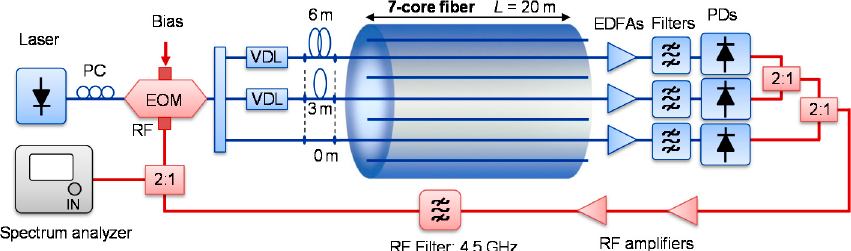
Figure 8. Setup for the experimental demonstration of a multi-cavity Vernier optoelectronic oscillator over a seven-core homogeneous fiber. PC: polarization controller; RF: radiofrequency; EOM: electro-optic modulator; VDL: variable delay line; EDFA: Erbium-doped fiber amplifier; VOA: variable optical attenuator; PD: photodetector (blue: optical path; red: electrical path) [59].